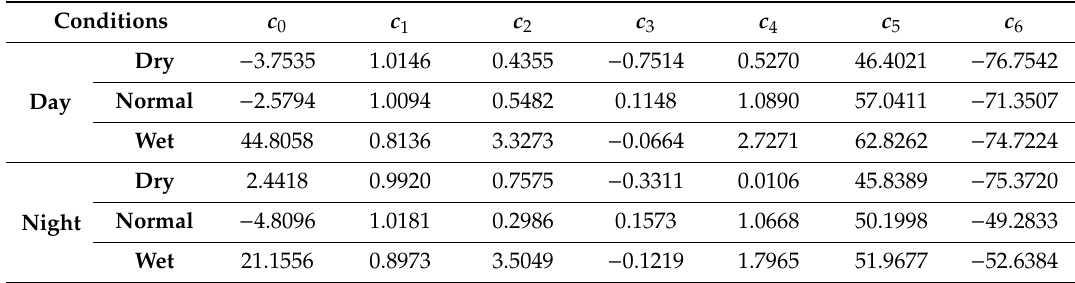
Table 3. The coe ffi cients of the GK2A / AMI equation (Equation (1)) according to the day / night and dry / normal / wet conditions.